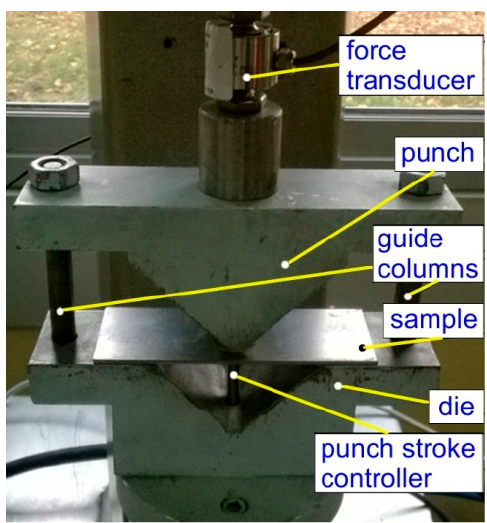
Figure 1. The experimental setup.